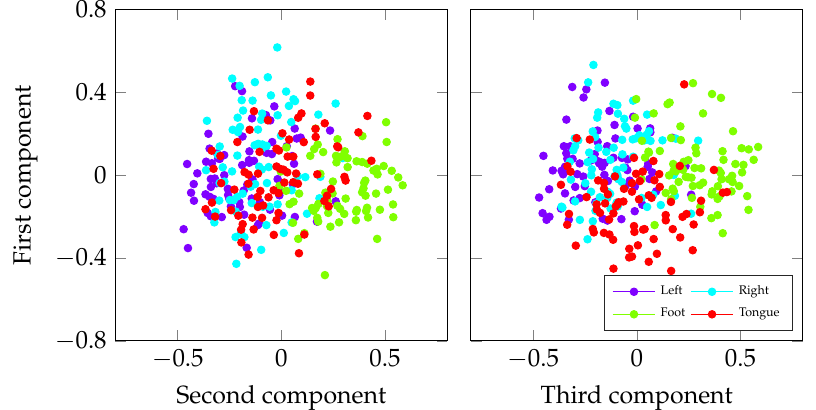
Figure 6. Resulting MKSSP kernel projected into three KPCA components for the worst-performing subject (S02).